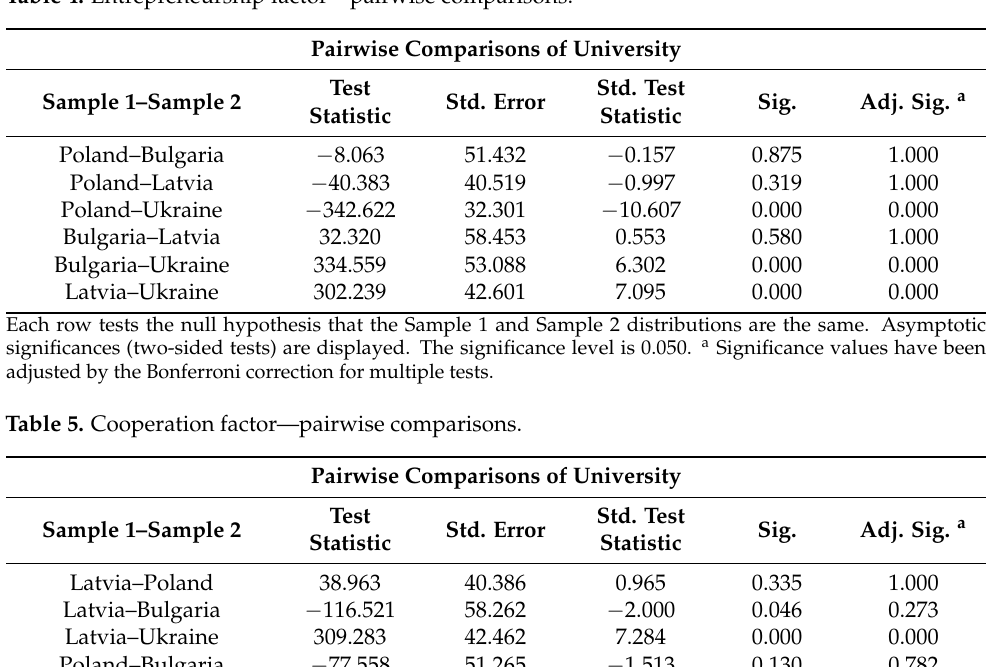
Table 4. Entrepreneurship factor—pairwise comparisons.